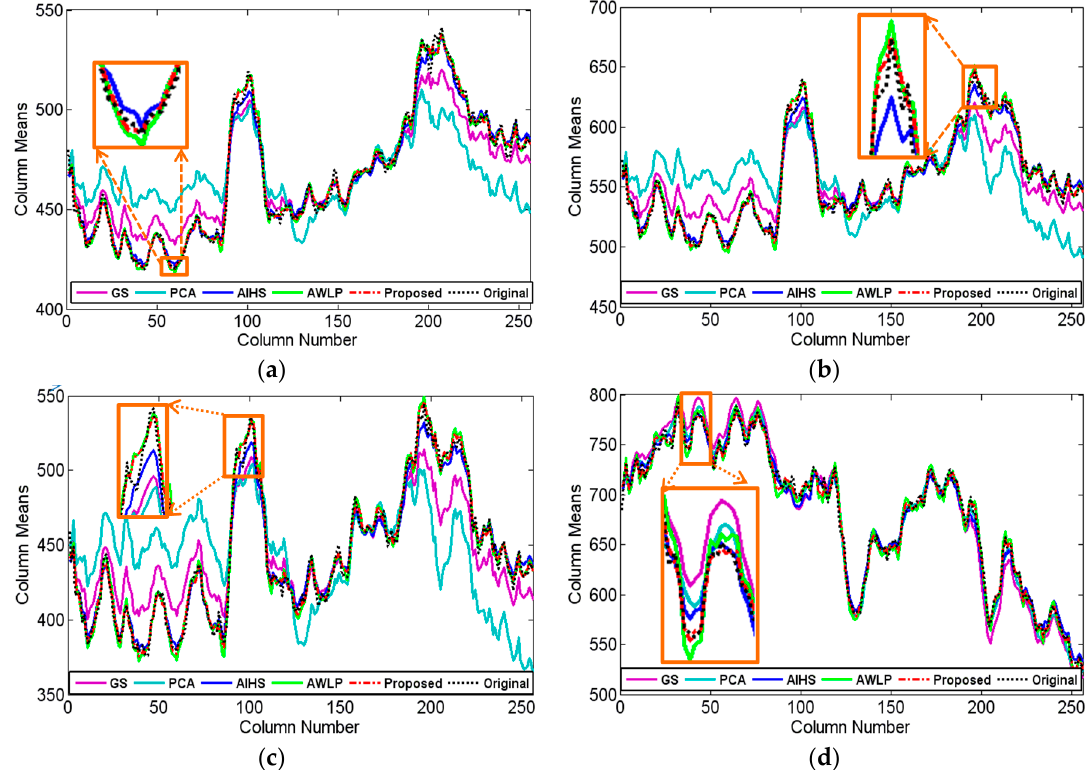
Figure 4. Horizontal profiles of the column means for the IKONOS fusion results. ( a ) band 1; ( b ) band 2; ( c ) band 3; ( d ) band 4.